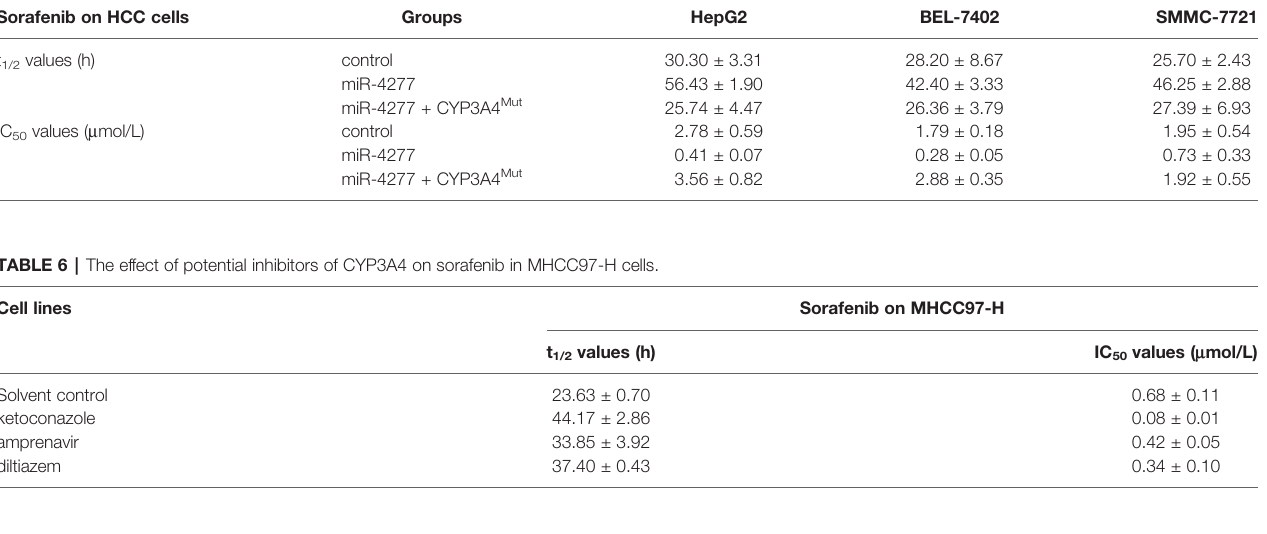
TABLE 5 | The effect of miR-4277 on sorafenib in HCC cells. Sorafenib on HCC cells